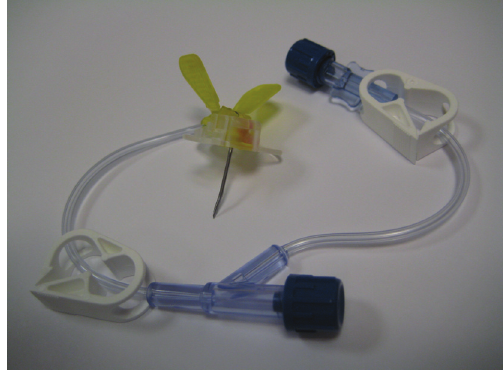
Figure 6: A Huber needle used to access an intravascular